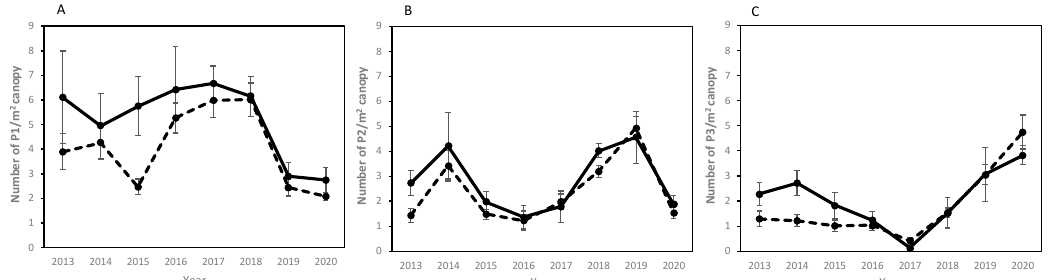
Figure 2. Average and standard error of the number of cones (P1, P2 and P3) divided by the m 2 of canopy separated by year and by rootstock. Dotted lines are the PP individuals and solid lines are the PH individuals. ( A ) Number of P1 divided by m 2 of canopy projection, ( B ) number of P2 divided by the m 2 of canopy projection, and ( C ) number of P3 divided by the m 2 of canopy projection.